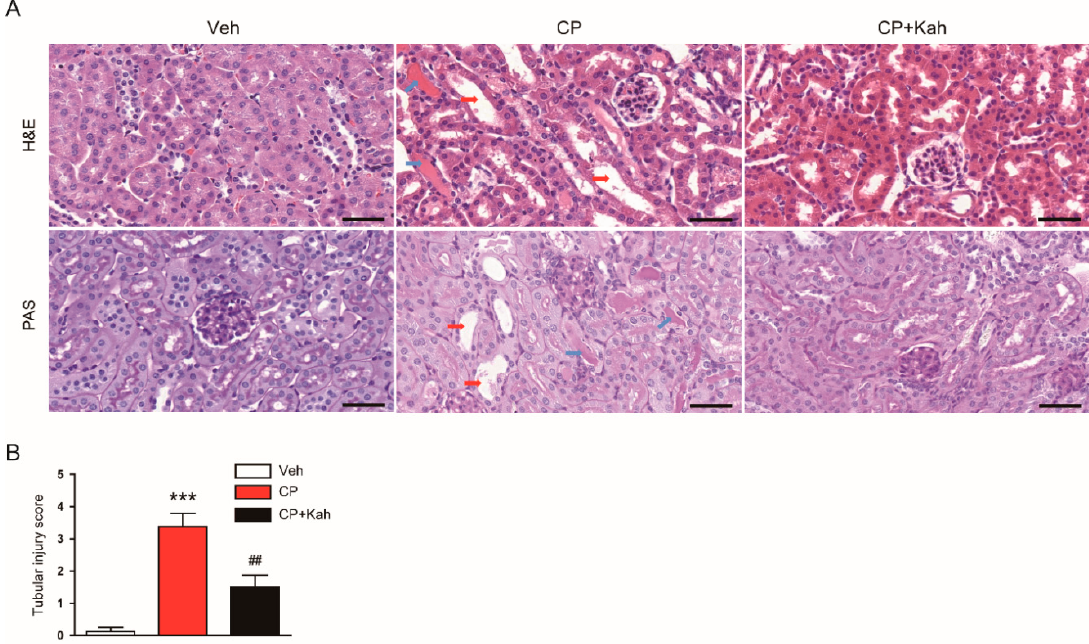
Figure 2. Histological features of the kidneys in all experimental groups. ( A ) Hematoxylin and eosin (H&E) and periodic acid-Schiff (PAS) staining of kidney tissues. Scale bar = 40 μ m. Red arrows indicate dilated tubules. Blue arrows indicate tubular cast deposition. ( B ) Tubular injury score. n = 8 per group. *** p < 0.001 vs. Veh. ## p < 0.01 vs. CP.